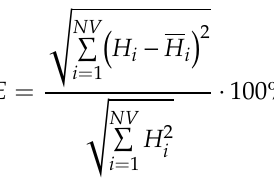
Figure 9. Impact force time histories for different equations.